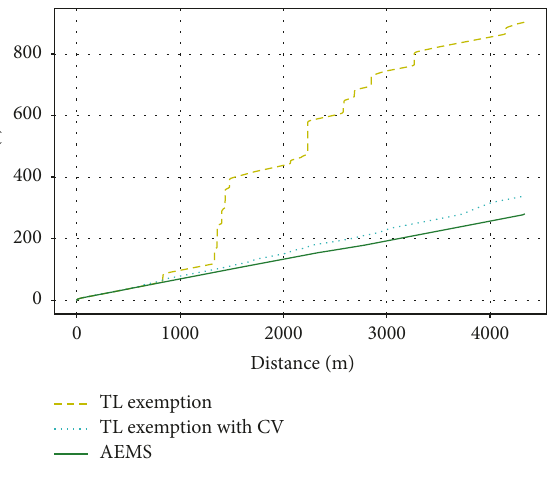
Figure 9: Response time of the